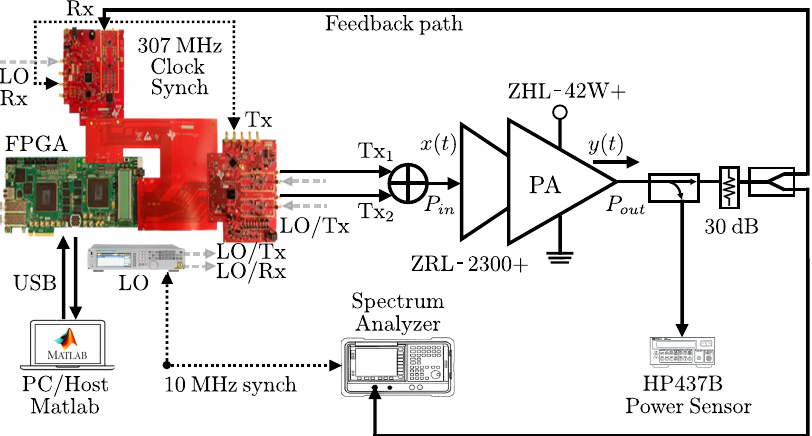
Figure 1. Experimental measurement testbed setup based on ARRIA V Board for a radio frequency power amplifier (RF-PA).